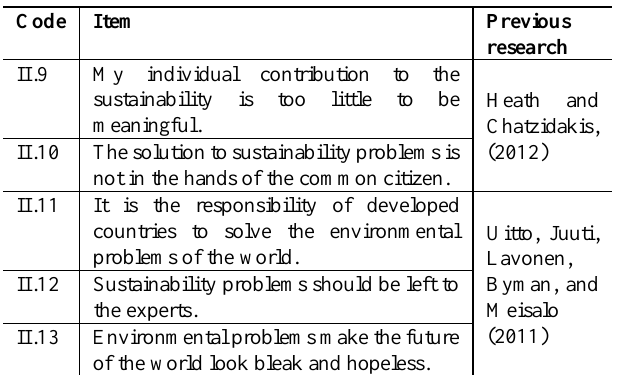
Table 2: Perception of personal responsibility Code